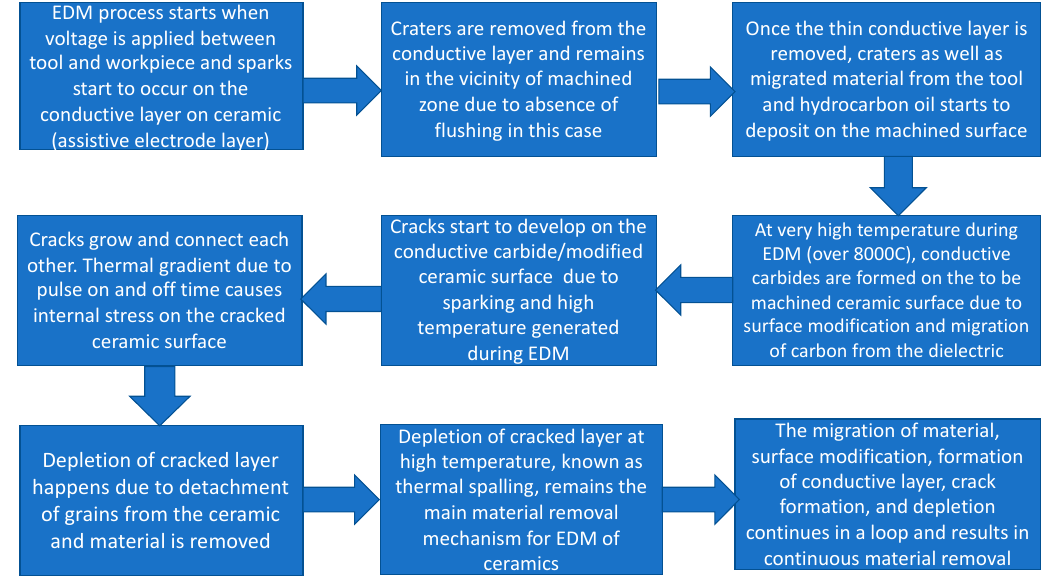
Figure 6. Step-by-step material removal mechanism during EDM of electrically non-conductive ceramic.